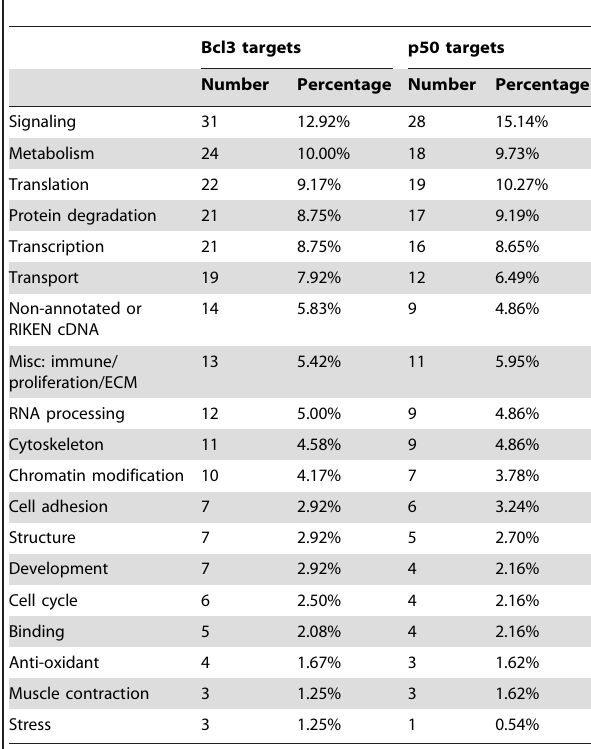
Table 1. Functional category of target genes for Bcl-3 and p50 from microarray